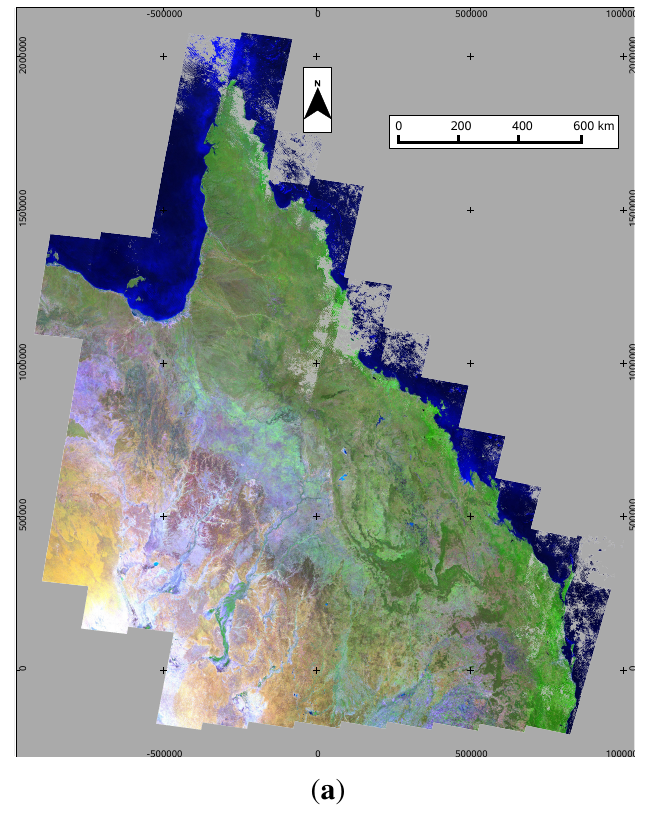
Figure 9. Mosaic of seasonal images for Queensland, for March–May 2008. ( a ) Medoid composite; ( b ) Maximum NDVI composite. Both images are stretched to the same maximum/minimum values. Colouring is with TM bands 5, 4, 1 as red, green and blue respectively. Null value is coloured as grey, showing areas where less than three values remained after masking for cloud and